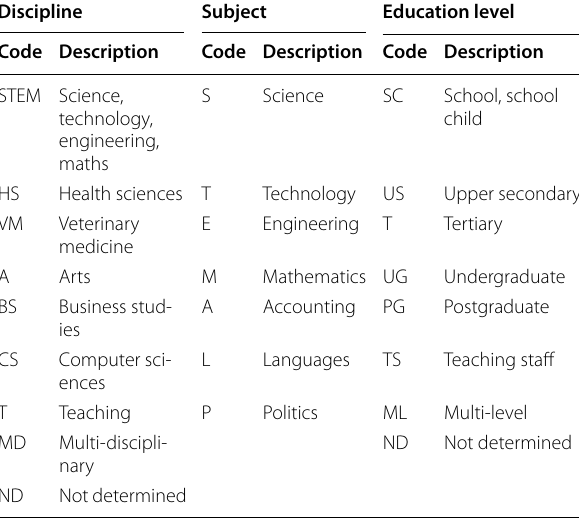
Table.1 Codes and descriptions for classification of the journal articles included in the